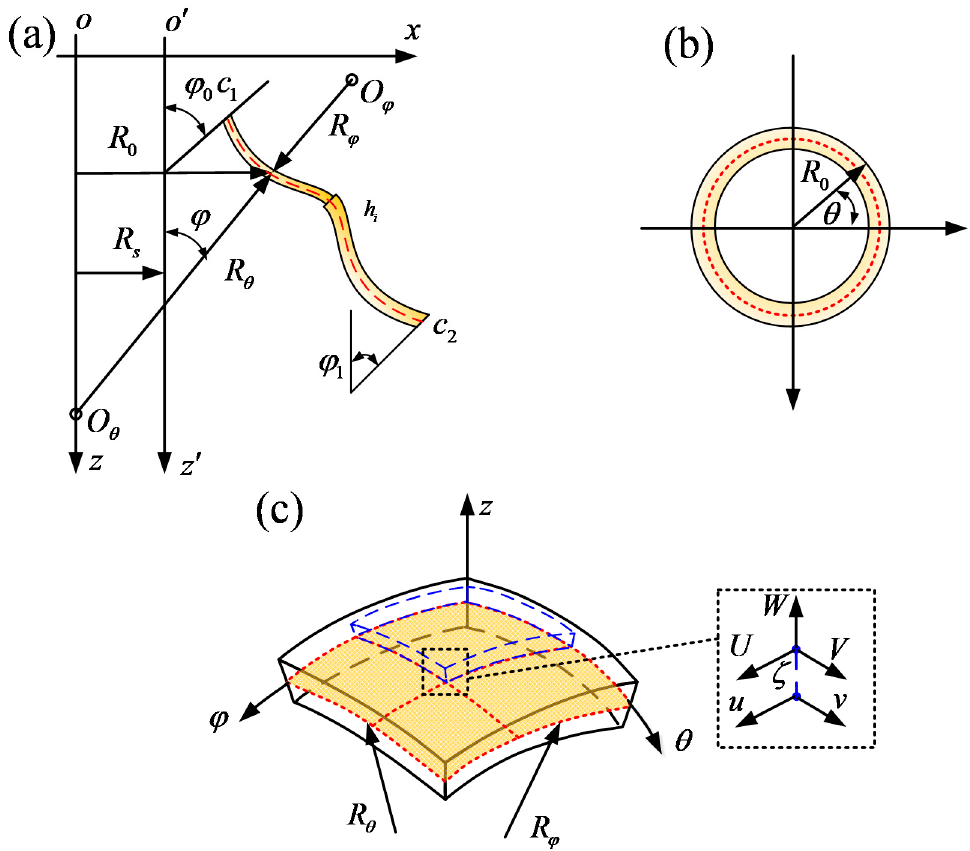
Figure 1. Geometry notations and coordinate system of stepped FG paraboloidal shell. ( a ) Geometric relationship; ( b ) cross-section; ( c ) coordinate system.